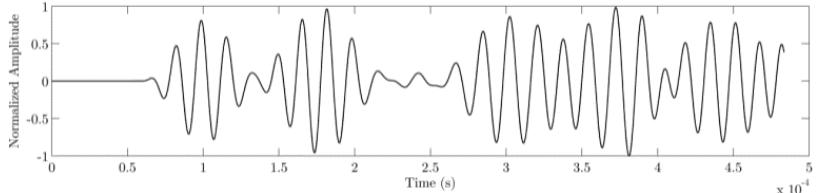
Figure 10. Signal acquired at 33 cm from excitation point at 60 kHz.